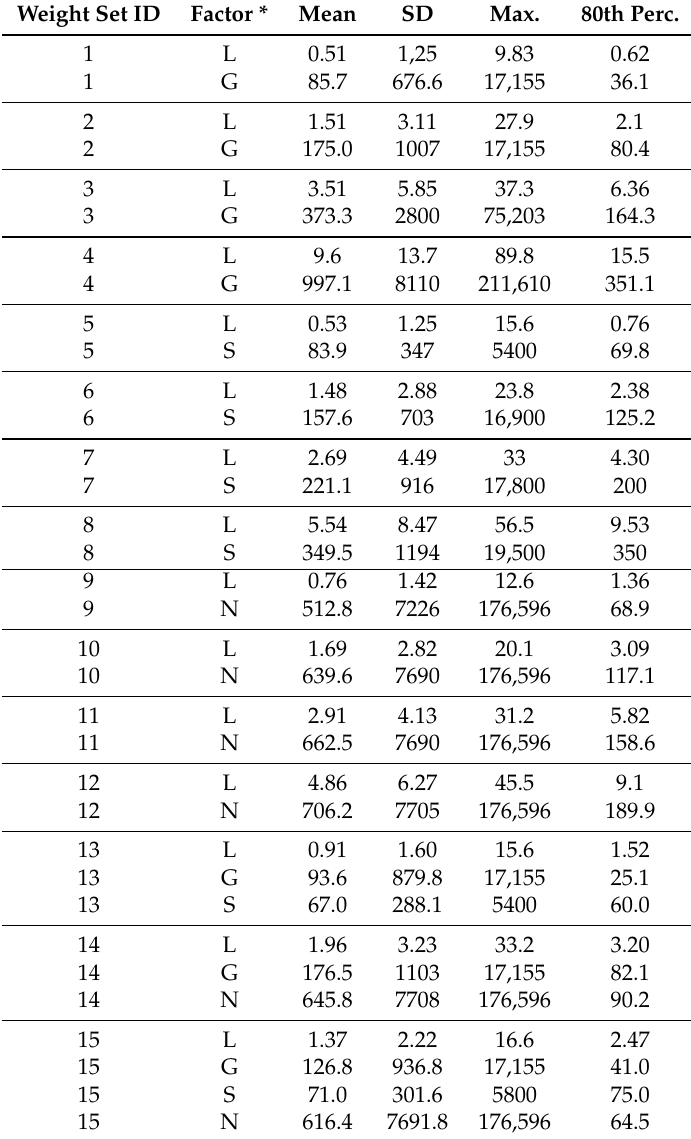
Table 5. Descriptive statistics of the p i metric (Equation (3)) computed for the length as well as the non-zero weighted factors of the fifteen weight sets presented in Table 4. These statistics were computed over the one-thousand randomly generated trips. * L, G, S, and N stand for the length, greenness, sociability, and noisiness factors,